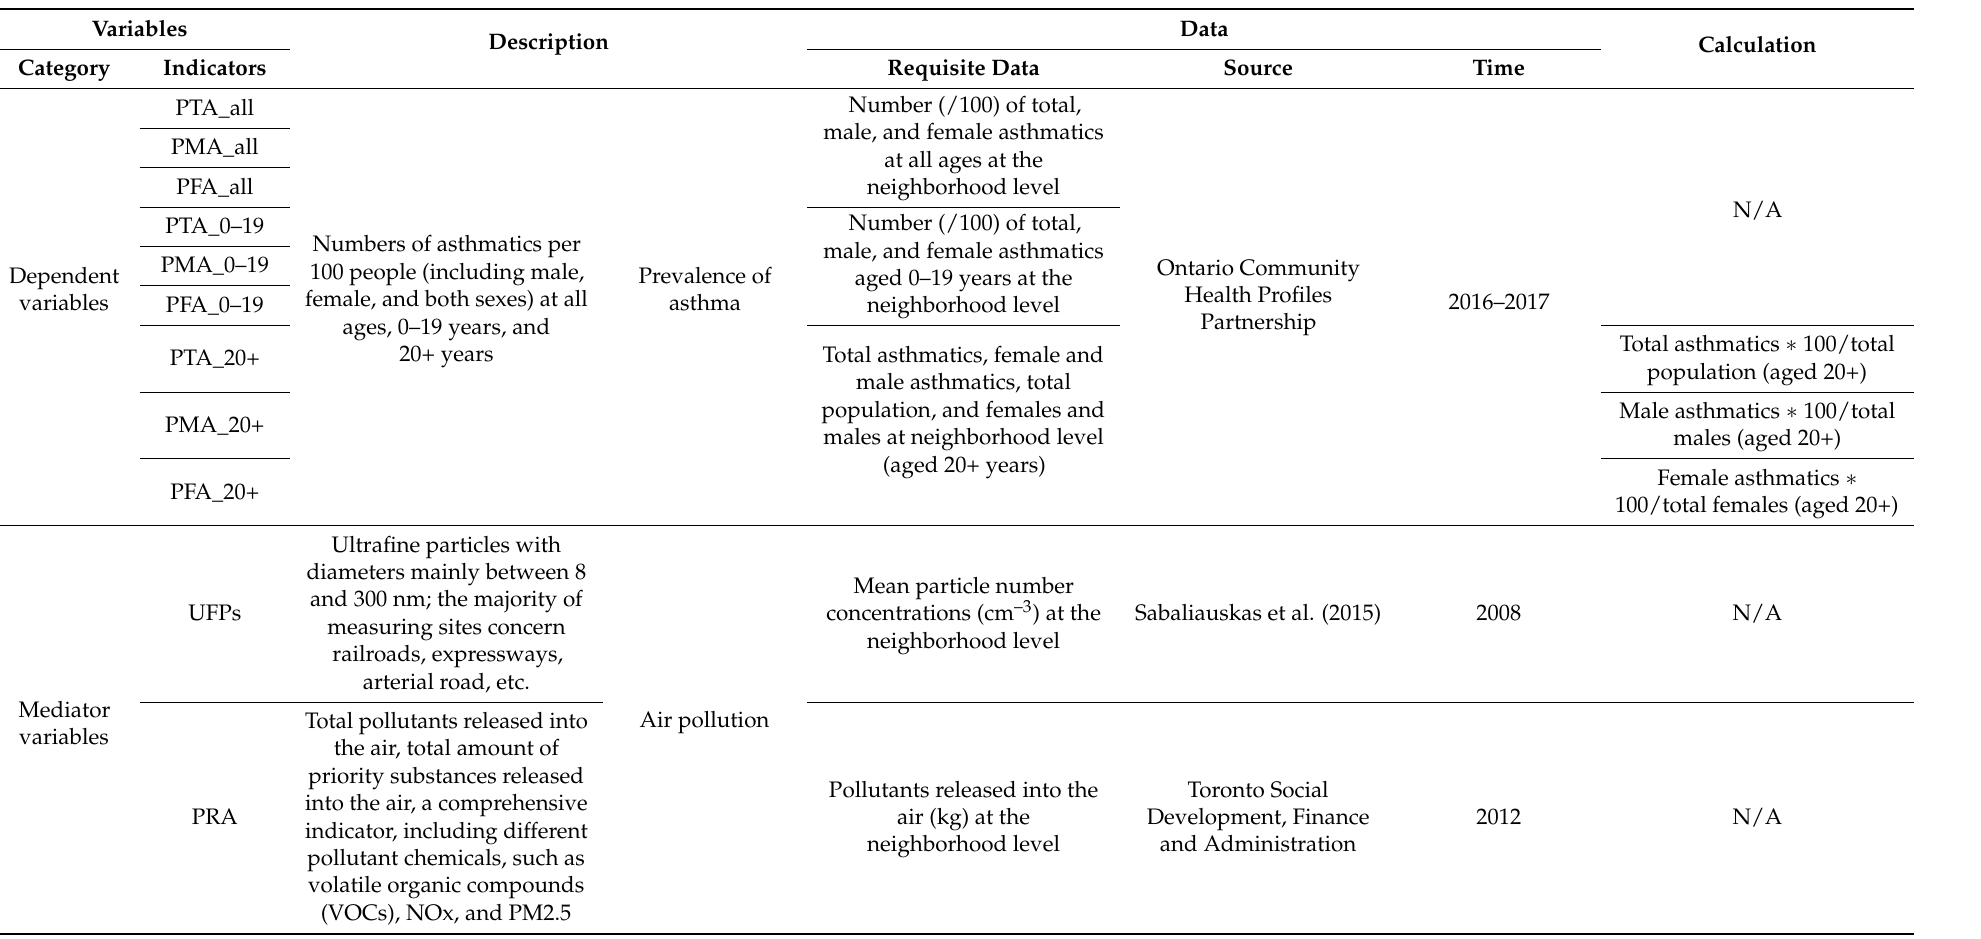
Table A1. Variables and requisite